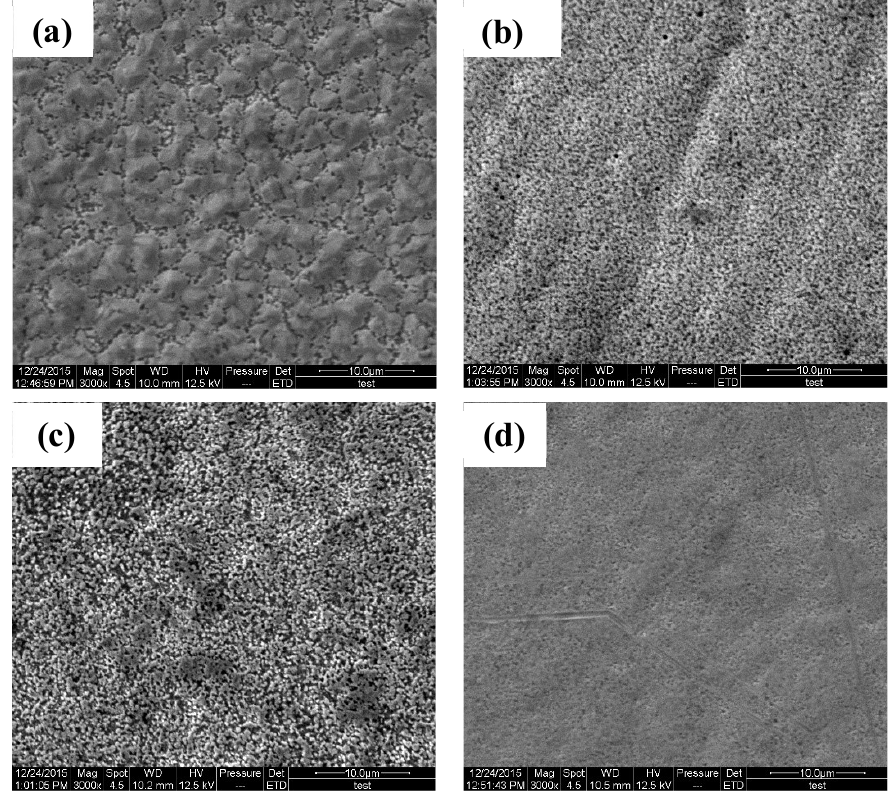
Figure 7. The SEM morphologies of corroded coatings: ( a ) Cu–Sn; ( b ) Cu–Sn–PTFE; ( c ) Cu–Sn–TiO 2 ; ( d ) Cu–Sn–PTFE–TiO 2 .